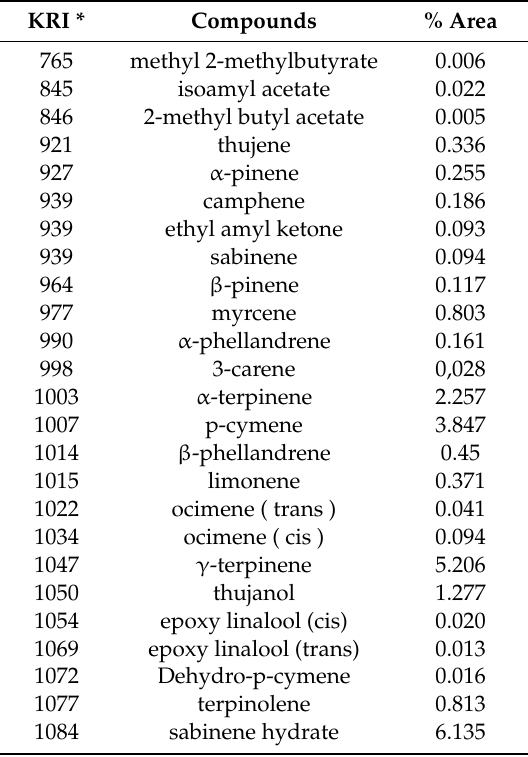
Table 1. Volatile compounds identified in Origanum onites essential oil (OOEO) by GC / MS analysis and their relative percent (%)